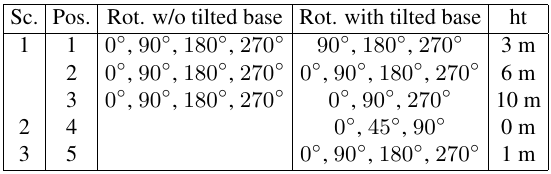
Table 1: Position numbers, sensor orientation and height above